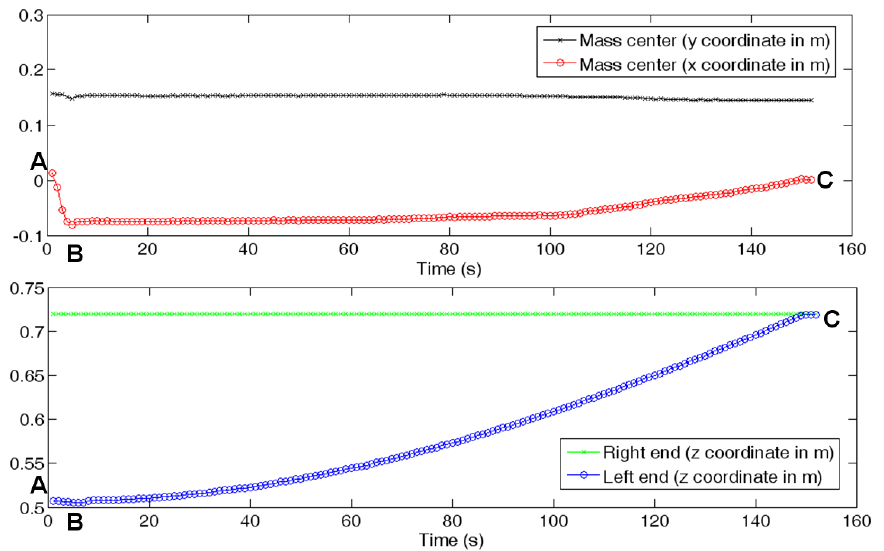
Figure 15. Trajectories of the mass center (top) and robot arm (curve in blue at the bottom